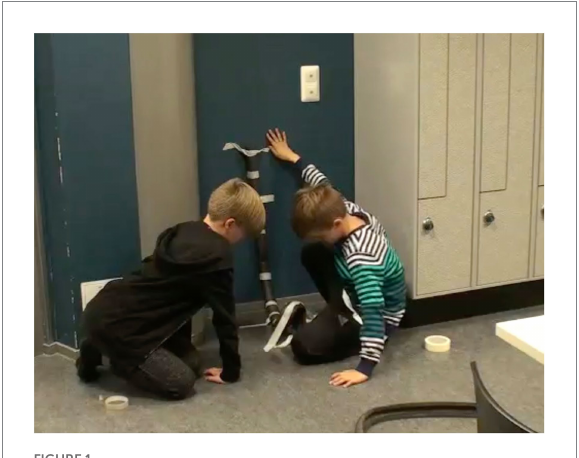
FIGURE 1 A typical roller coaster construction in the FUSE Studio makerspace.